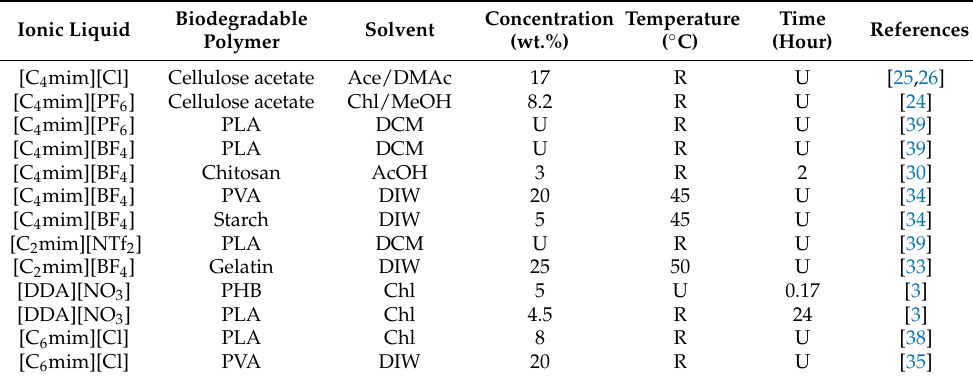
Table 6. Ionic liquids, biodegradable polymers, solvents, biodegradable polymer concentrations, dis- solving temperatures, and dissolving times applied for the preparation of electrospinning